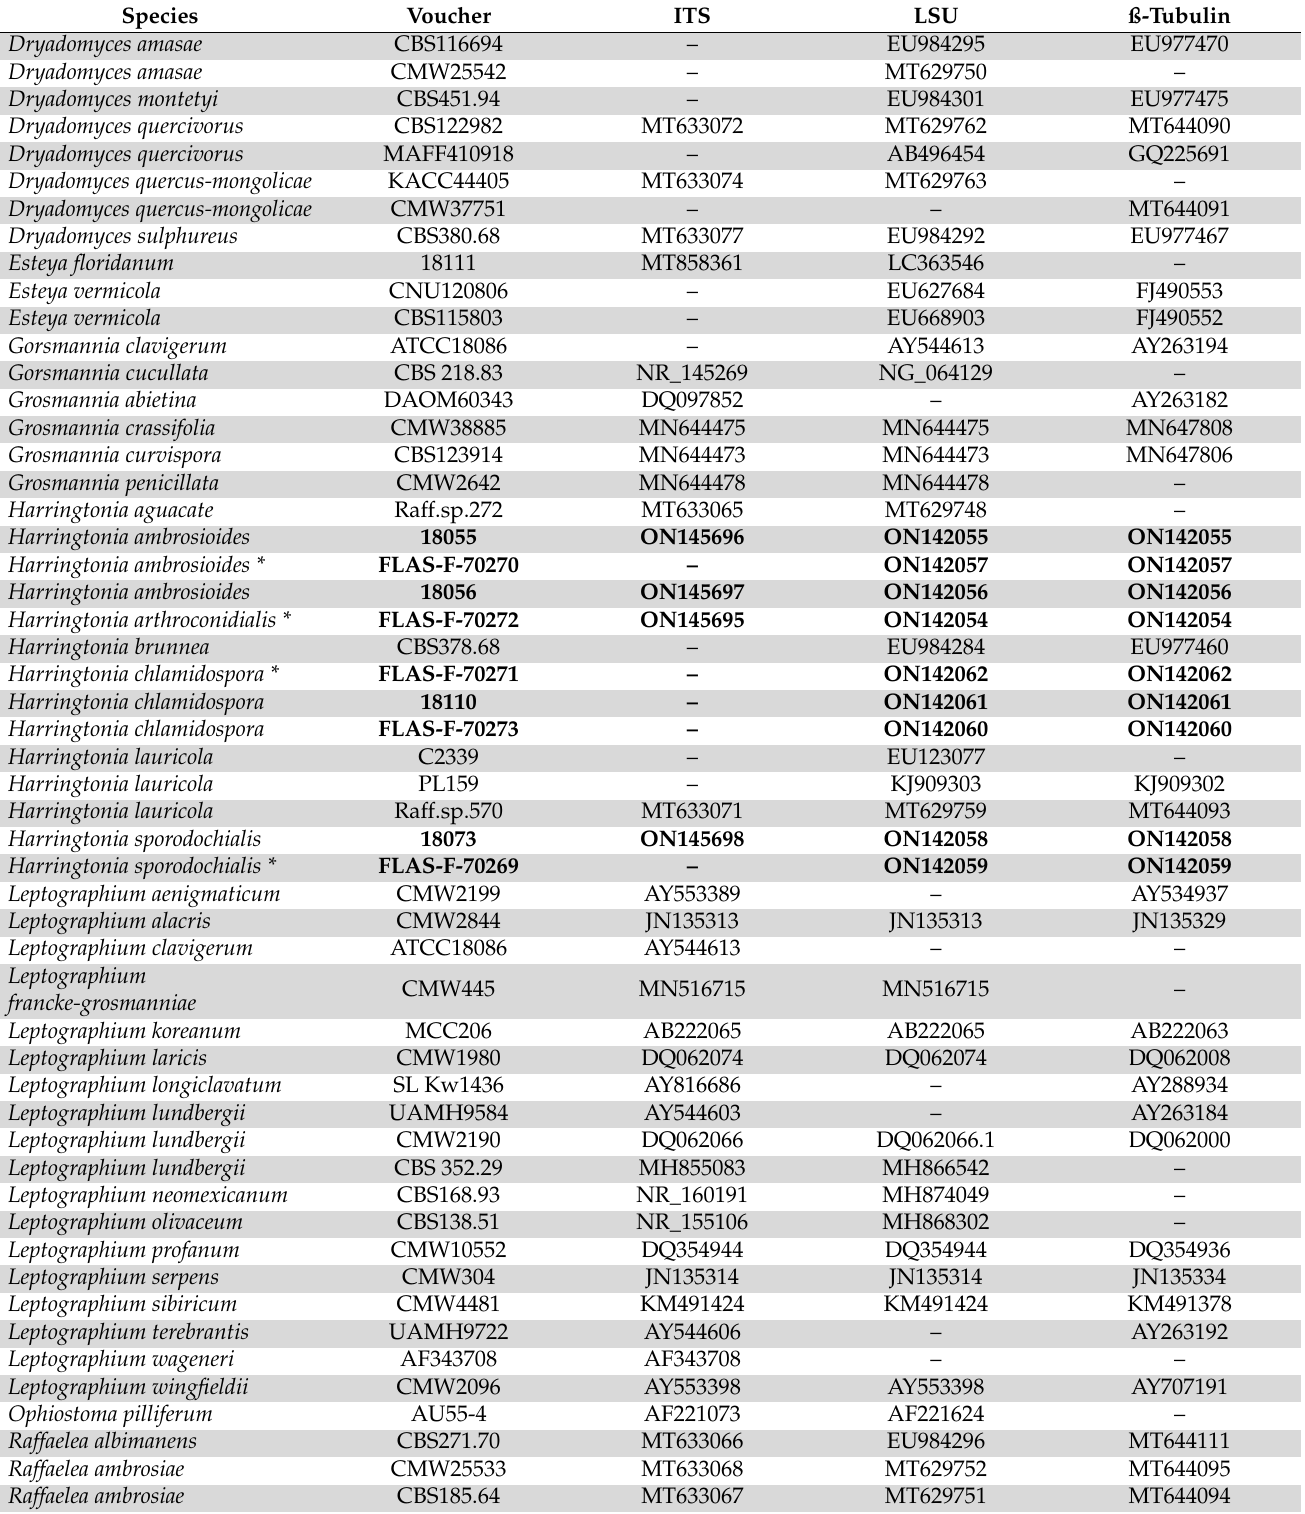
Table 2. Species, Voucher and GenBank information of the species used in this study (Figure 1). The new species proposed in this study is highlighted in bold with types marked with